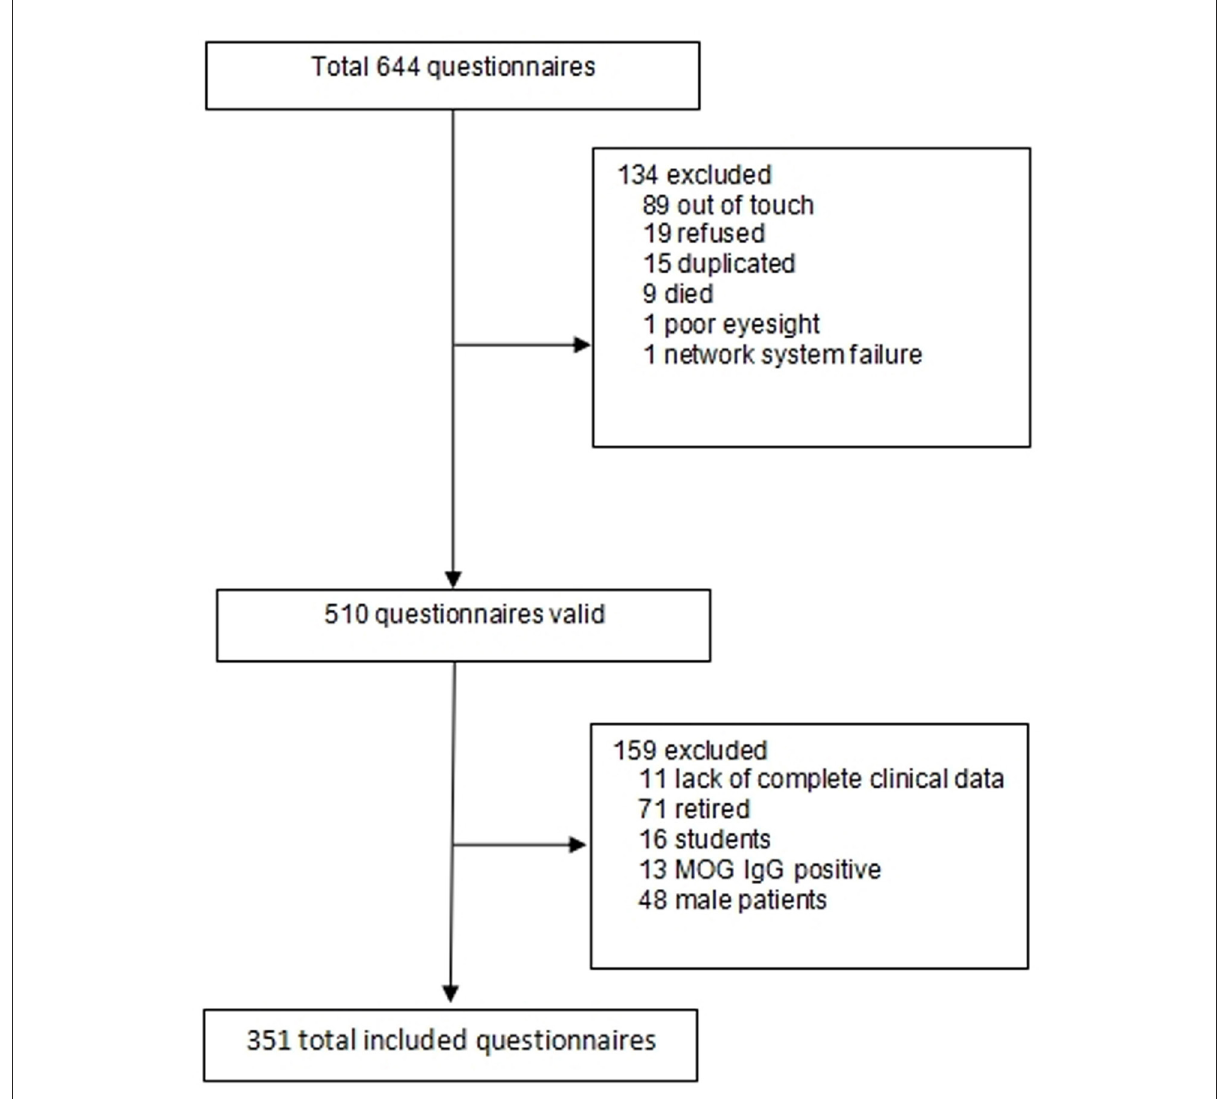
FIGURE1 Flowchart of the patient selection process for this questionnaire